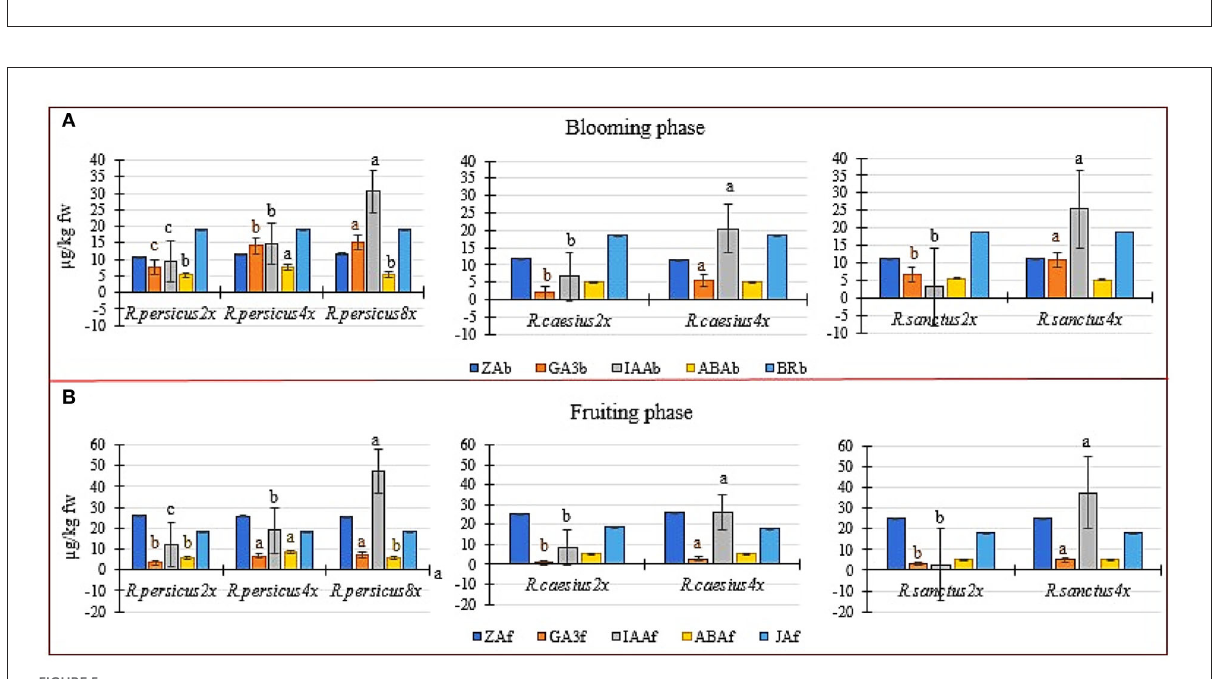
FIGURE5 The phytohormones’ content in diploid and autopolyploid plants in three blackberry species at the blooming and fruiting phase. (A) The concentration of zeatin (ZA), gibberellic acid (GA 3 ), indole acetic acid (IAA), abscisic acid (ABA) and brasinoestroid (BR) in the flowering stage of di and polyploid in R. persicus , R. caesius and R. sanctus . (B) the concentration of ZA, GA 3 , IAA, ABA and jasmonic acid (JA) in the fruiting stage of di and polyploid in R. persicus , R. caesius and R. sanctus. In each species, means followed by the same letters are not significantly different according to the LSD test at P ≤ 0.05 and the columns with no letters were not